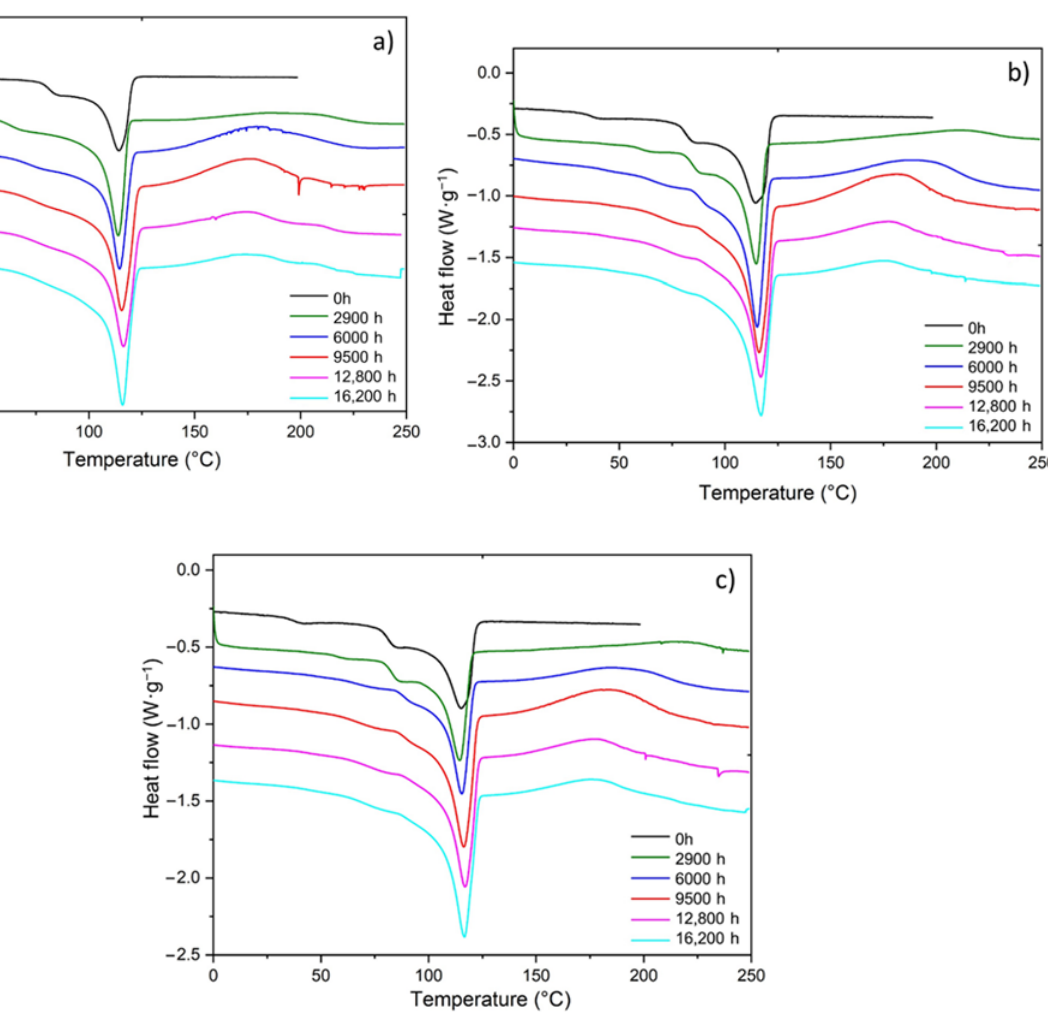
Figure 2. Changes in the DSC thermogram of the Si ‐ XLPE matrix filled with 0 phr ( a ), 25 phr ( b ), and 50 phr ( c ) of ATH, during radio ‐ thermal exposure in air under 8.5 Gy ∙ h − 1 at 47 °C.